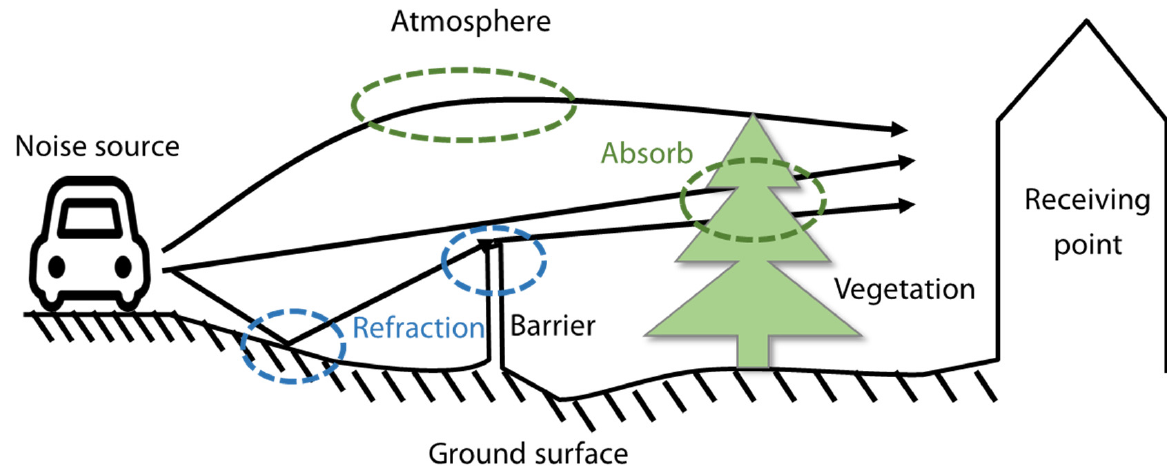
Figure 3. Overview of the traffic noise propagation process (modified from [37]).